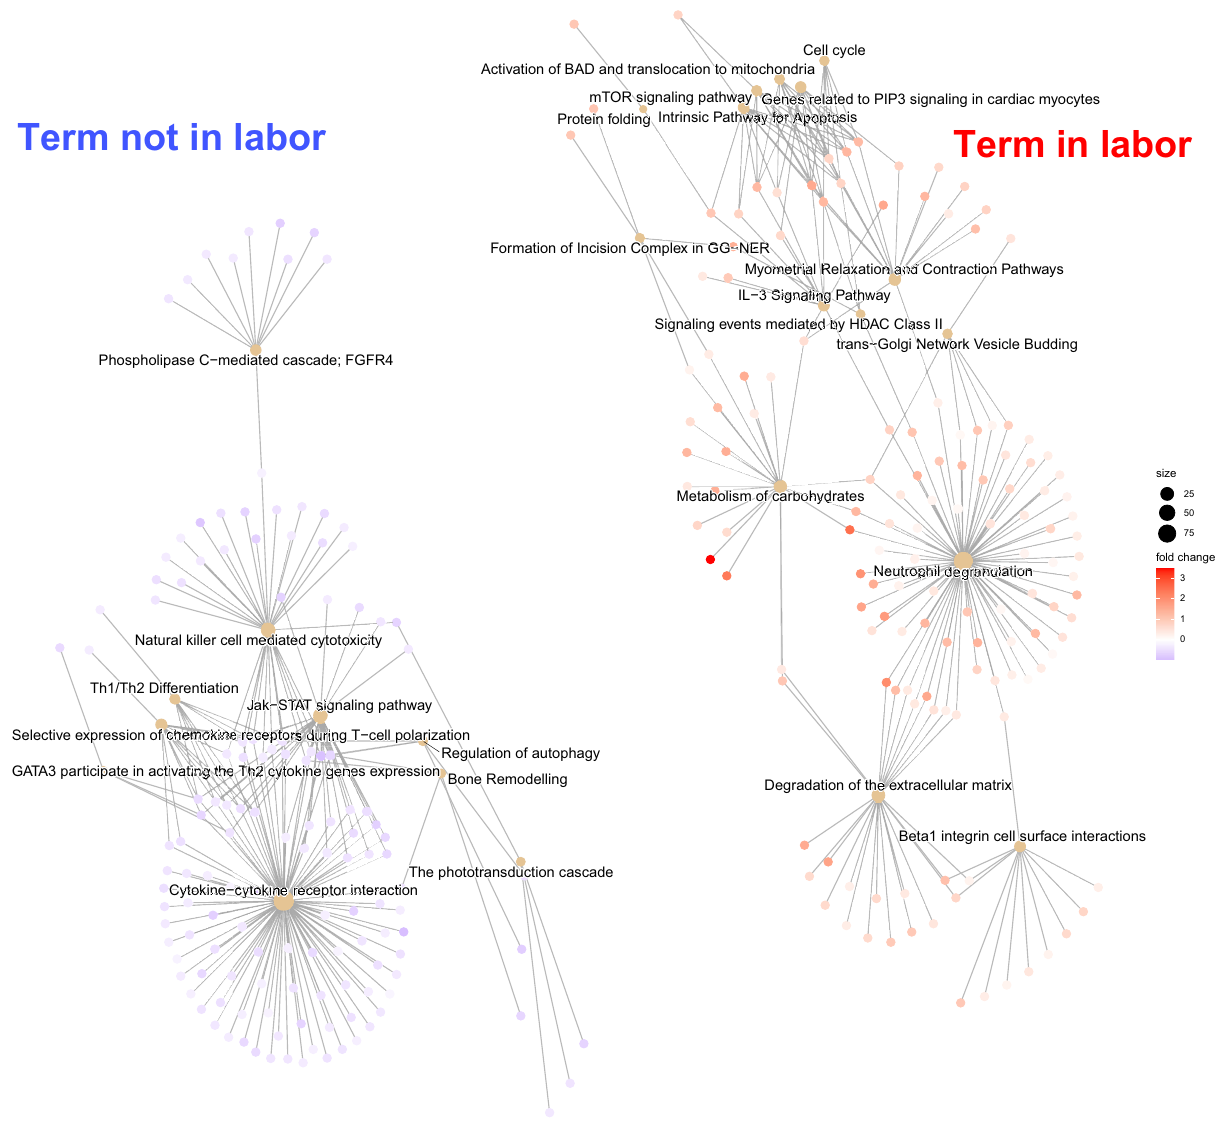
Figure 4. Functional enrichment of biological pathways in the amniotic fluid proteome with and without labor at term. Gene-concept network (cnetplot) of biological pathways that were significantly enriched (q-value < 0.1) before (blue) or after (red) the onset of labor. The size of the nodes, corresponding to enriched terms, represents the number of member genes that contributed to the enrichment (leading edge) of the term. The color of the nodes representing each leading-edge gene indicates the TIL/TNL fold change in the corresponding protein abundance. The relationships between the enriched terms are represented by the shared genes. The R/ Bioconductor package, clusterProfiler 162 was used to generate the